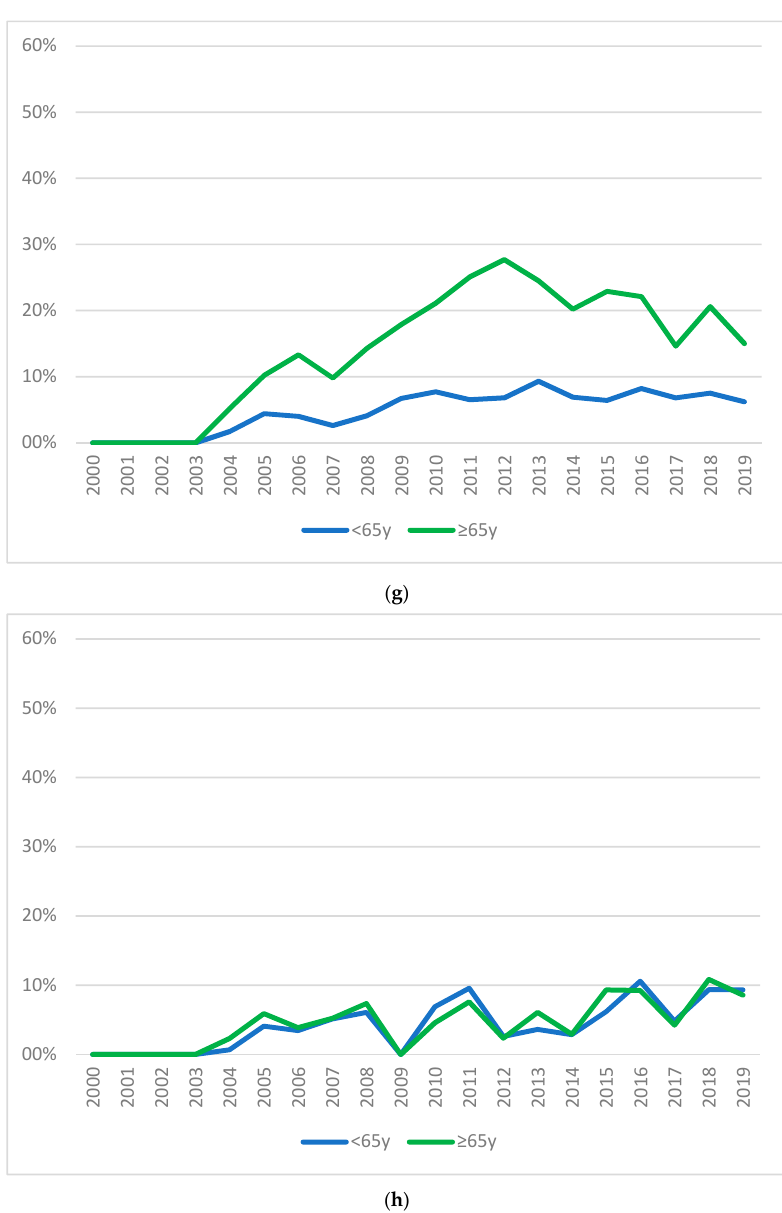
Figure 5. Trends over time of percentage of reasons for referrals for the subgroups NOV65 and OV65. ( a ) Abuse of alcohol/drugs/psychotropic drugs; ( b ) Anxiety; ( c ) Delirium; ( d ) Depression; ( e ) Medical Unexplained Physical Symptoms; ( f ) Pre-OLTx; ( g ) Psychomotor agitation; ( h ) Re-evaluation of psychopharmacological therapy.